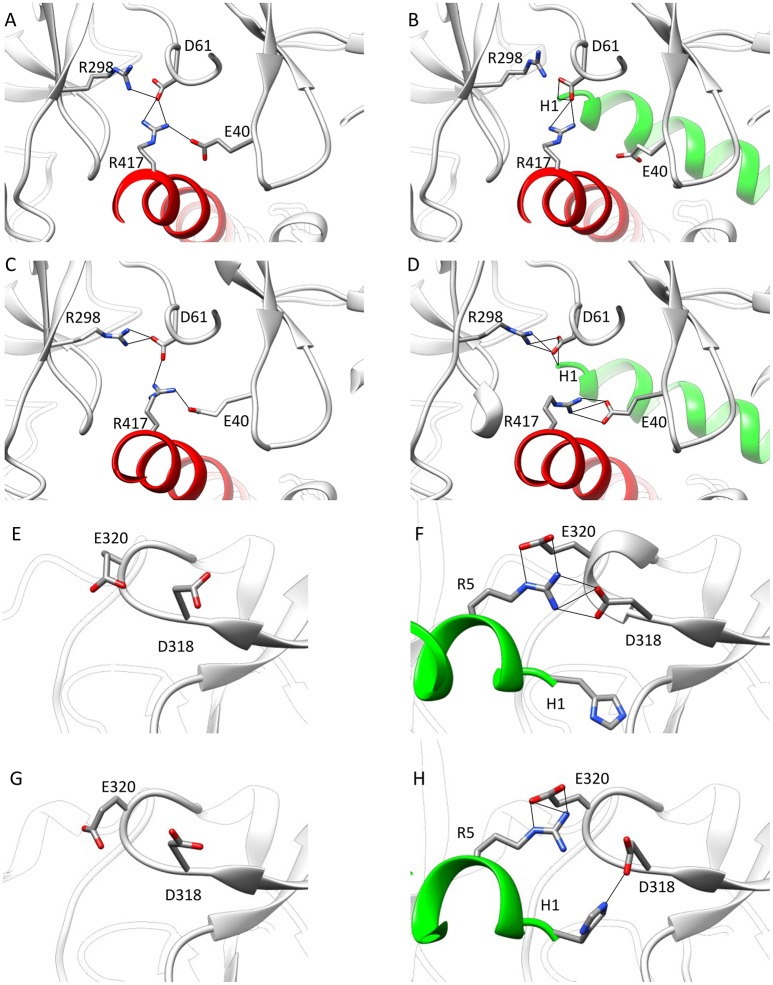
Interaction networks in NTR and CM2. (A–D) the NTR hydrogen bond network E40-R417-D61-R298. (A,B) Closed state of NTR. The interactions between E40 and R417 (A) are disrupted by introduction of DPcpvtN2
(B). (C,D) Open state of NTR. Interaction between R417 and D61 (C) are disrupted but interaction between D61 and R298 is strengthened by introduction of DPcpvtN2
(D). (E–H) the CM2 hydrogen bonding network. (E,F) closed state of NTR; (G,H) open state of NTR. A hydrogen bonding network is formed in CM2 (F,H) between D318 and E320 from domain B and H1 and/or R5 from DPcpvtN2. The central helix is shown in red; DPcpvtN2 is shown in green.